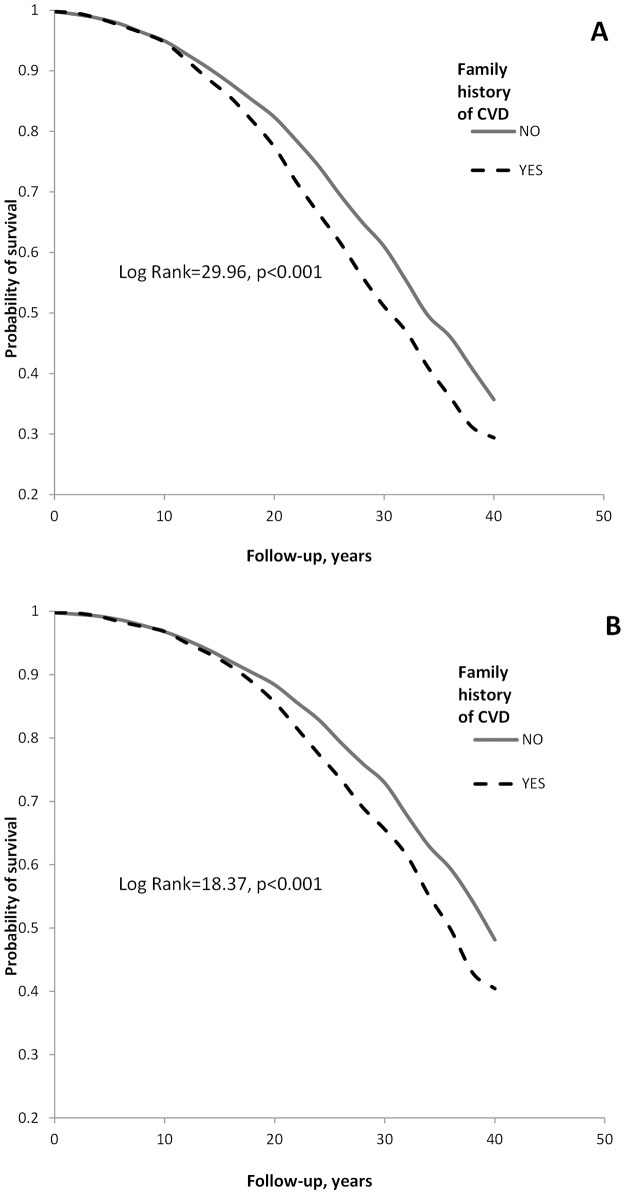
Probability of survival for cardiovascular disease (CVD) mortality (panel A) and coronary heart disease (CHD) mortality (panel B) according to the presence of first-degree relatives with CVD (myocardial infarction or/and stroke or/and sudden death).